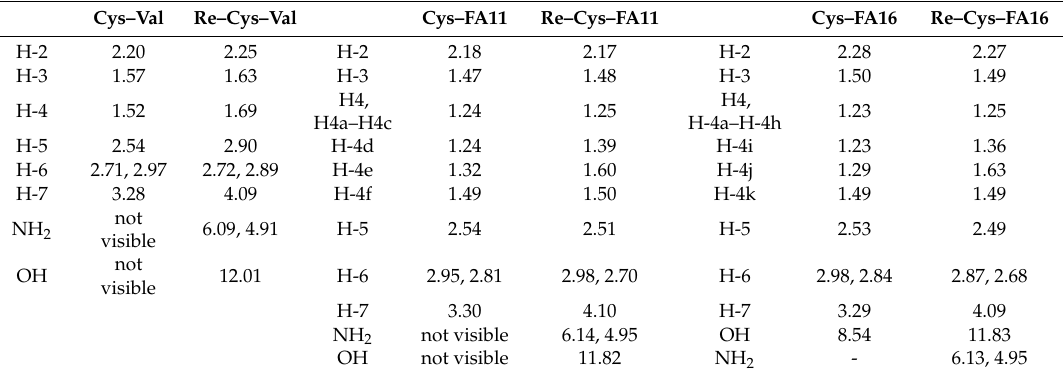
Table 1. 1 H NMR chemical shift assignments for ligands Cys–Val , Cys–FA11 , Cys–FA16 and complexes. Re–Cys–Val , Re–Cys–FA11 , Re–Cys–FA16 in DMSO- d 6 at 25 ◦ C. The numbering of the atoms is given in Scheme 1.